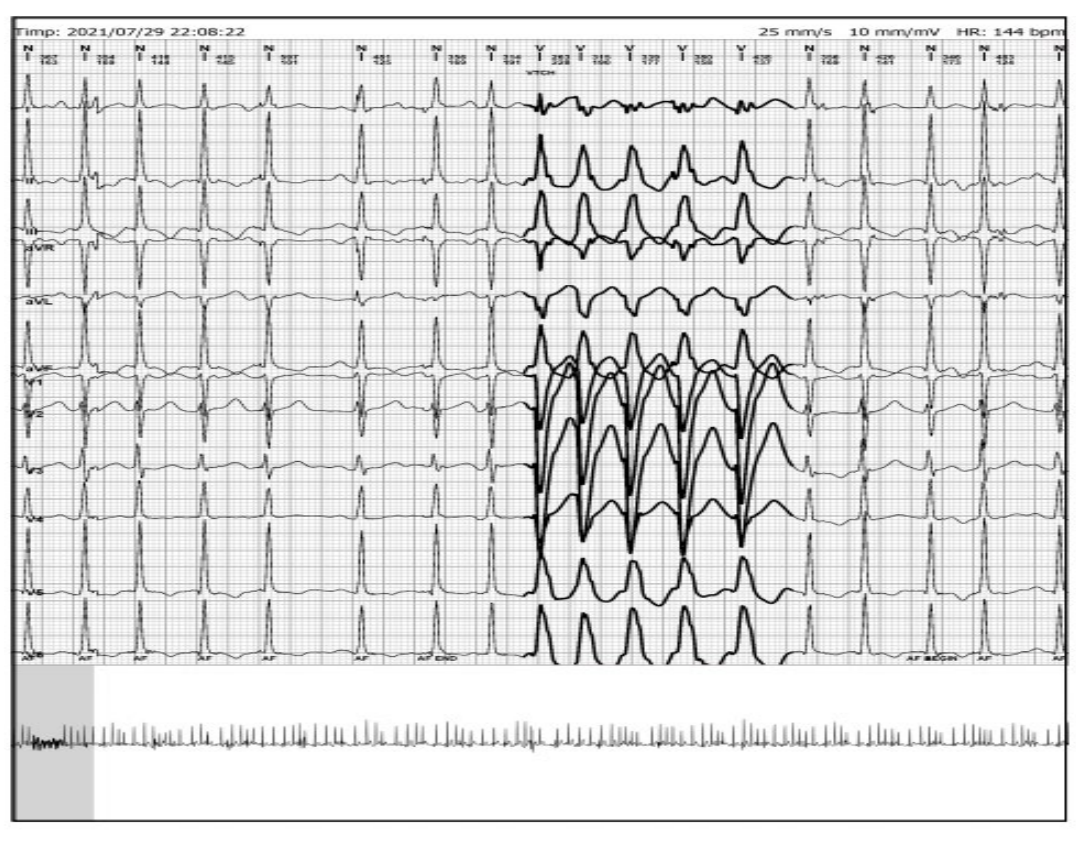
Figure 5. Case 1— Additional ECG monitoring showing atrial fibrillation and non-sustained ventricular tachycardia. QRS axis changes, with wide QRS complex.